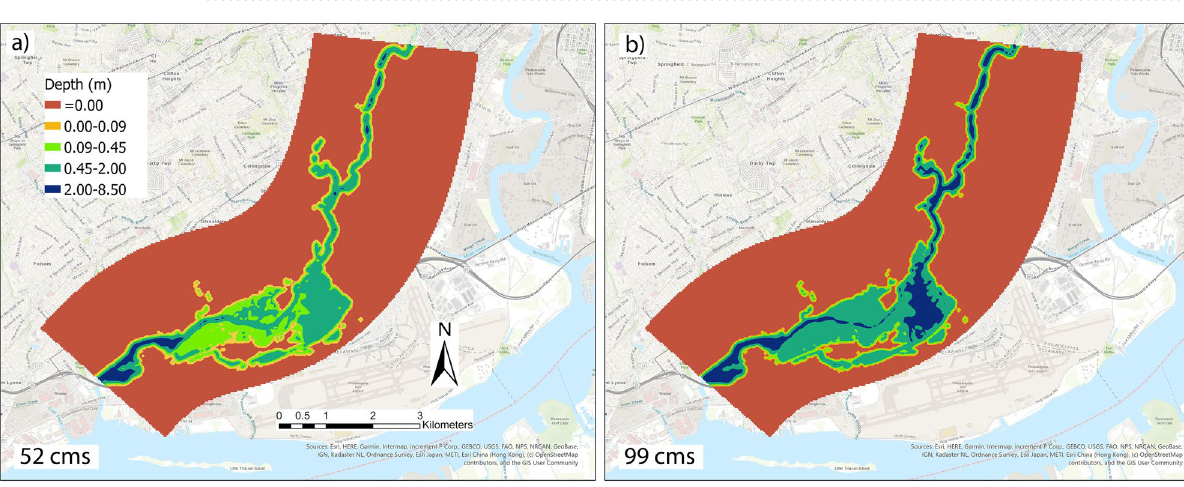
Figure 6. Flooding extent and depth estimated by the FaSTMECH solver in the iRIC platform for the scenarios with discharge values ( a ) 52 and ( b ) 99 cms. These scenarios are used to train/test ML classifiers and DNN regression algorithm. Maps are processed and generated in the ArcGIS Pro platform 81